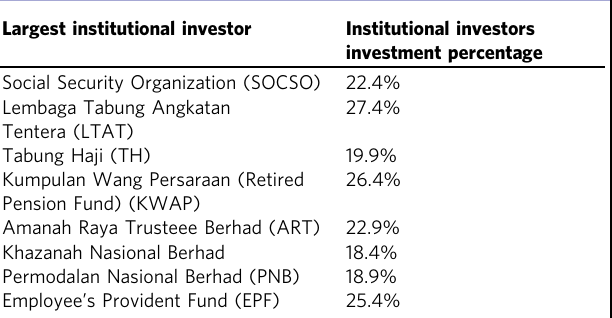
Table 1 Summary of largest institutional